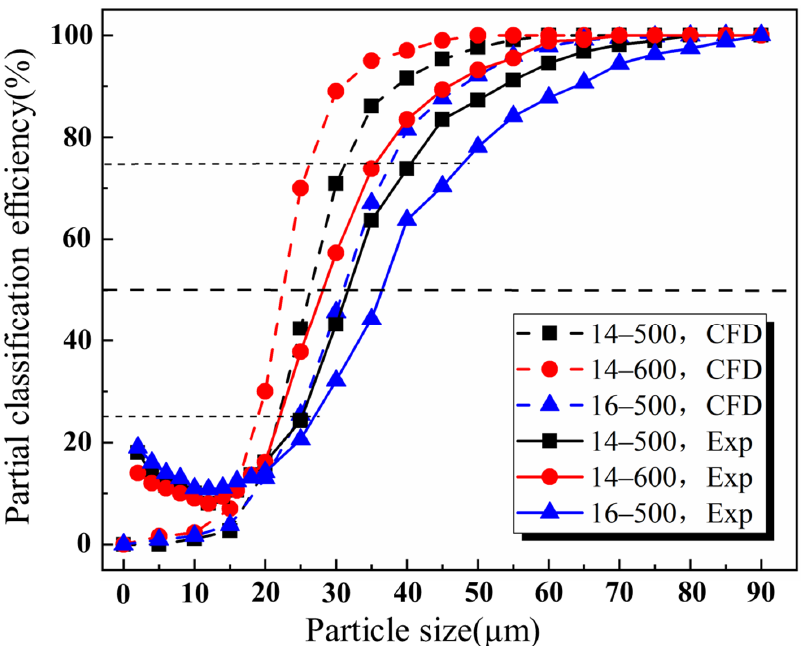
Figure 18. Tromp curves for the experiment and simulation.